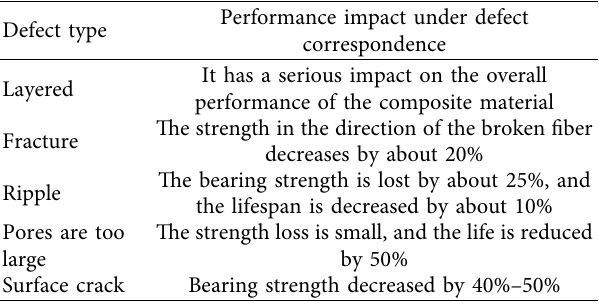
Figure 4: Graph of temperature and resistance changes during heating. Table 2: Composite defect types and their impact on